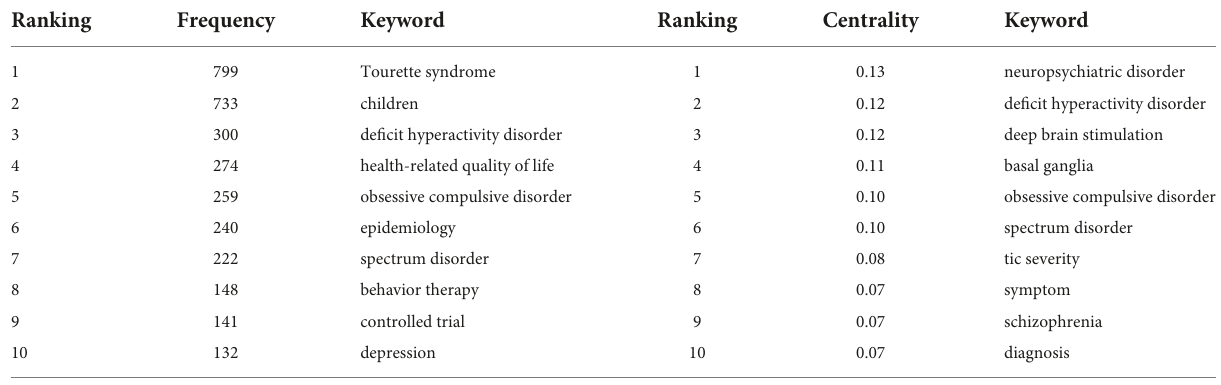
TABLE 7 The top 10 keywords related to Tourette Syndrome (TS) in children research from 2011 to 2021.